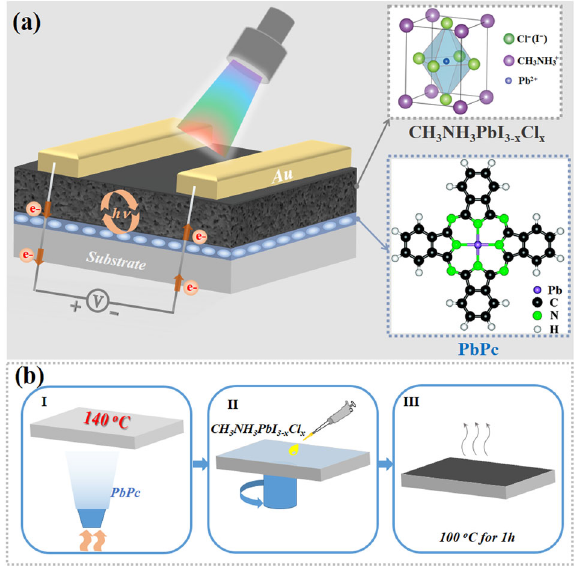
Fig. 1 Schematic con fi guration and fabrication for achieving an organolead halide perovskite-phthalocyanine heterostructured photodetector. a Schematic diagram of PbPc/MAPbI 3 − x Cl x photo- detector. b Fabrication scheme for the formation of PbPc/MAPbI 3 − x Cl x fi